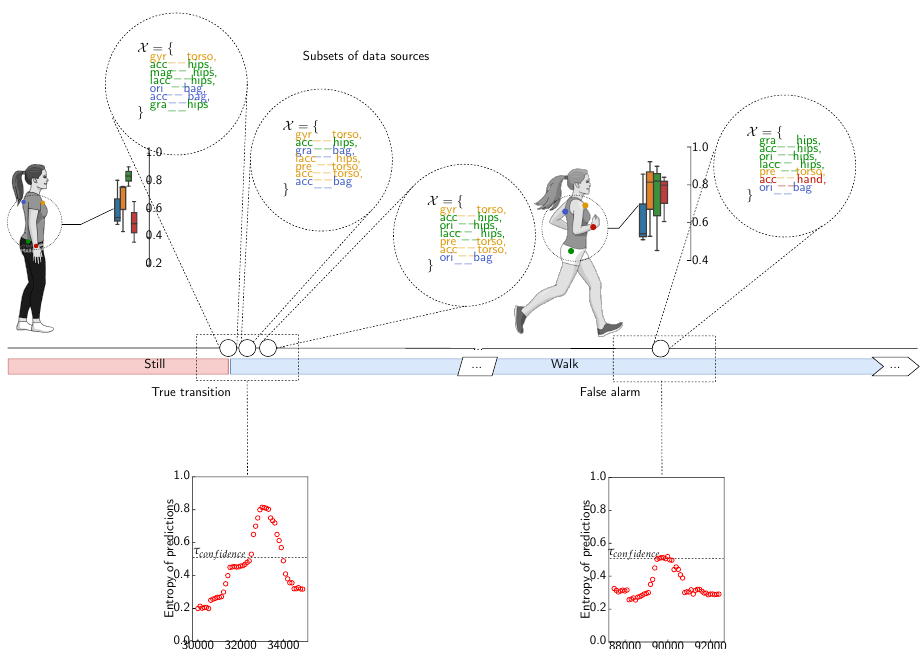
Figure 24. Timeline showing a real scenario of activity transition from Still (in red) to Walk (in blue). In addition to the true transition , a false alarm is triggered by the model during the walking activity. At the top of the timeline, the subsets of data sources are consecutively leveraged when the model detects a transition (true or false). At the bottom of the timeline, the two graphs show the evolution of the model’s predictions entropy monitored continuously against the confidence threshold ( τ confidence ). Figure adapted from [25].